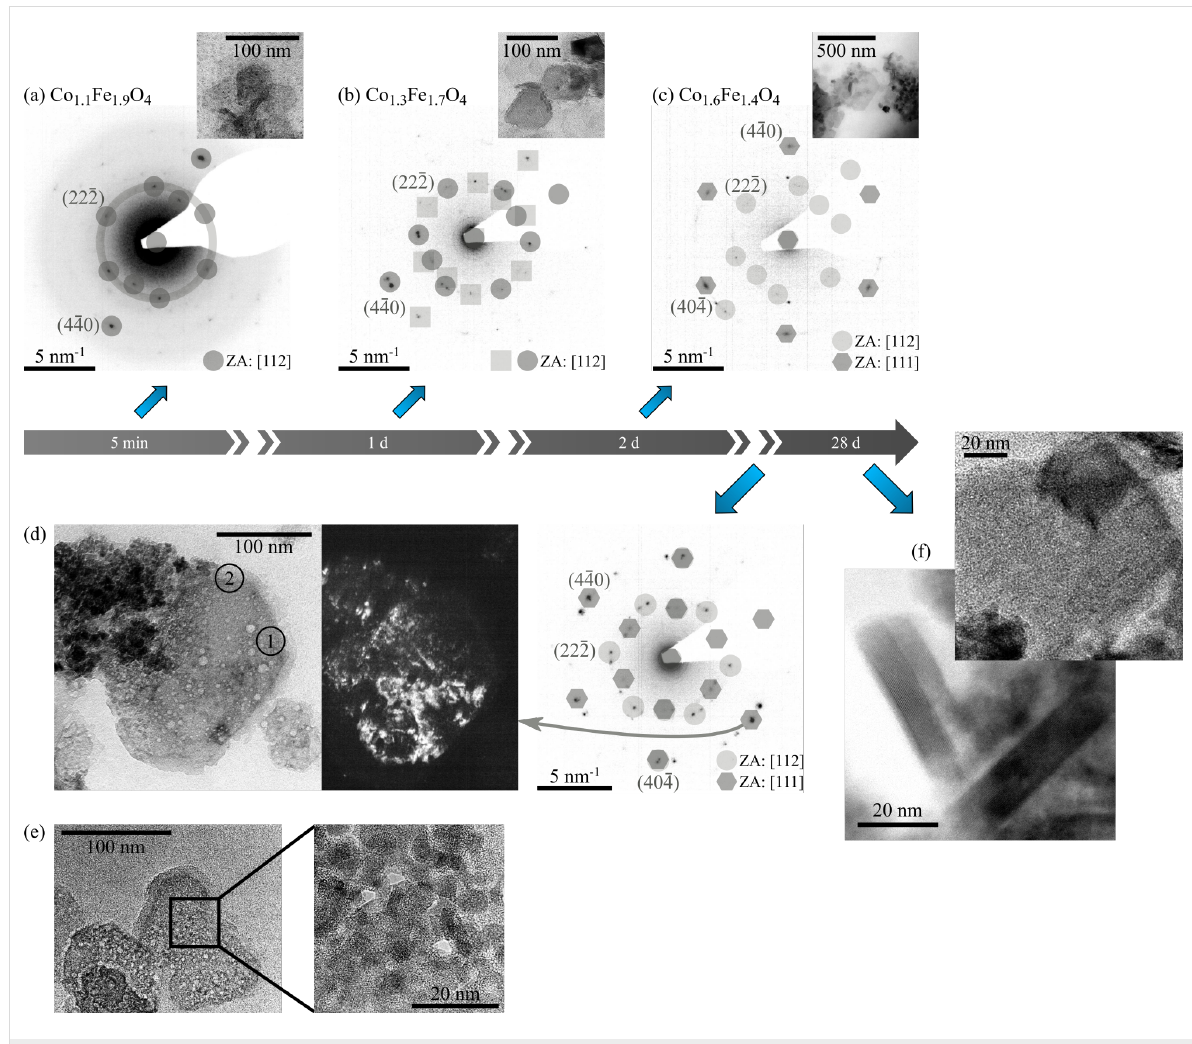
Figure 3: Top: Change in the electron diffraction pattern of diamond shaped particles with time. The inverted electron diffraction pattern is given here. (a) t = 5 min, (b) t = 1 d, (c) t = 2 d. Bottom: HRTEM images of incomplete particles. (d) Dark field image of an incomplete diamond-shaped particle as well as the corresponding electron diffraction pattern of the disc. The highlighted areas in the dark field image correspond to the specific reflex of the electron diffraction pattern. The inset of (e) shows an enlarged area within the disc. This disc is composed of smaller subunits.(f) HRTEM image of a final, stoichiometric monocrystalline disc, obtained after 28 days. The inset shows that the final nanoparticles are not porous. Only the dominating reflexes are indexed for reasons of clarity.